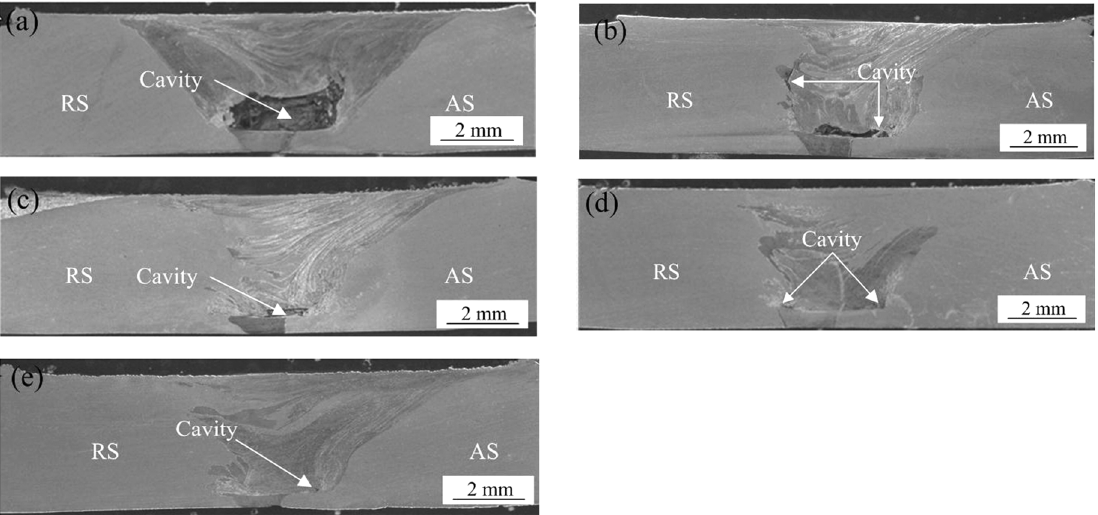
Figure 7: Macrostructure of cross section of joints under different tool offsets: (a) 0 mm, (b) 0.2 mm, (c) 0.4 mm, (d) 0.6 mm and (e) 0.8